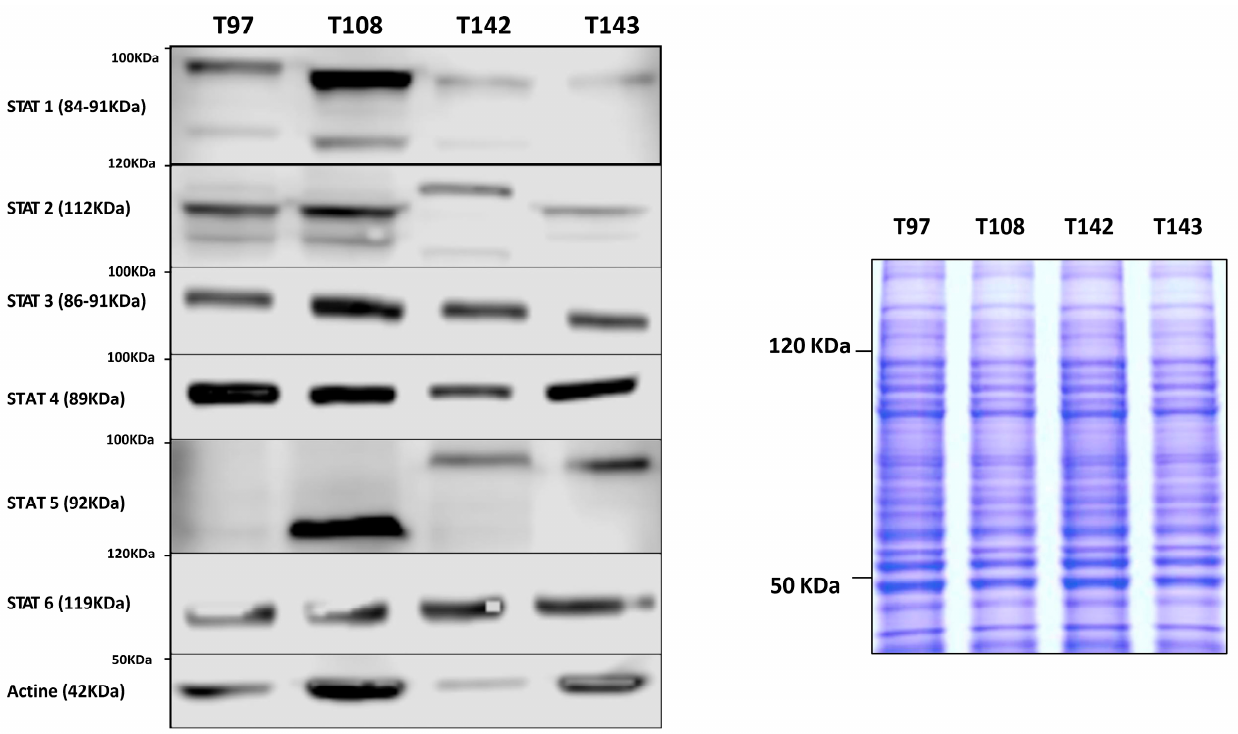
Figure 2. Western blot analysis of the STAT isoforms in UM cells. Total proteins isolated from the UM cell lines T97, T108, T142 and T143 were Western blotted using polyclonal antibodies directed against all STAT isoforms (STAT1 to STAT6). Actin was also blotted as a control. Coomassie blue staining (25 μ g of each protein extract was used) is also shown beside the Western blots as a protein loading control. UM cell lines were found to express all STAT proteins to varying levels. In addition, the metastatic T142 cell line expresses a STAT2 isoform with an apparent molecular mass higher than that observed in the remaining UM